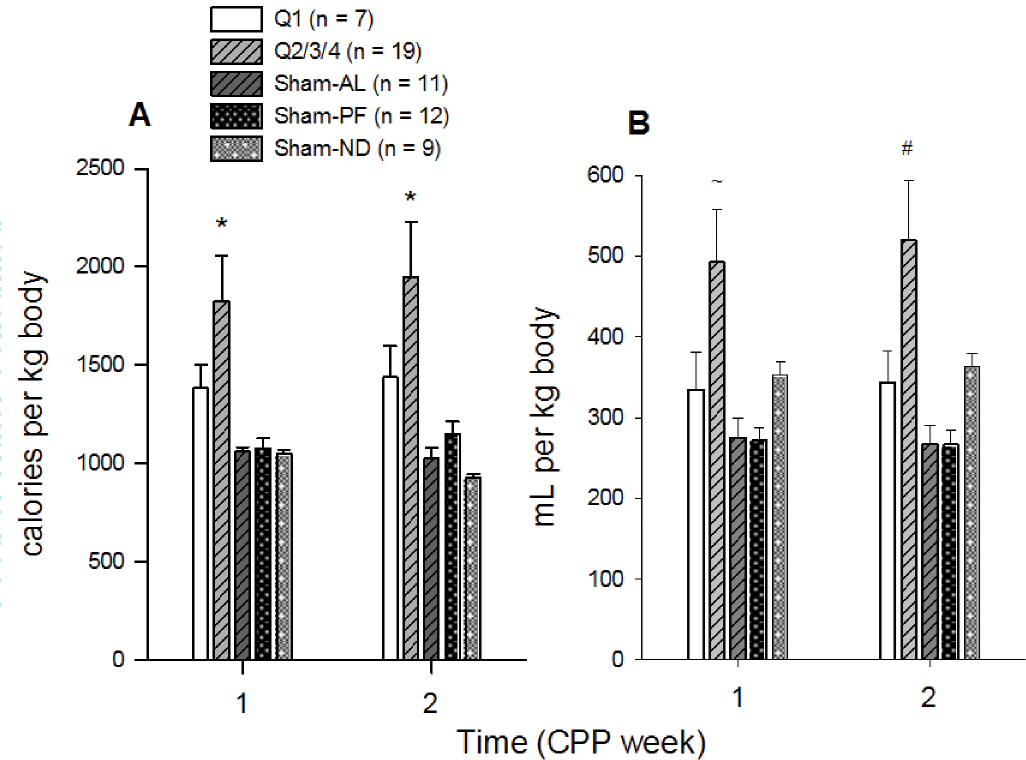
Fig 4. Weekly food and water intake during bacon- and chow-conditioning. Weekly food (A) and water (B) intakes were calculated relative to CPP Weeks 1 and 2, and these values, expressed in calories and volume consumed, respectively, were adjusted based on body-weight ( * unadjusted p < 0.001 versus Sham-AL,-PF and-ND; ~ unadjusted p < 0.001 versus Sham-PF and-AL; # unadjusted p < 0.007 versus all groups).